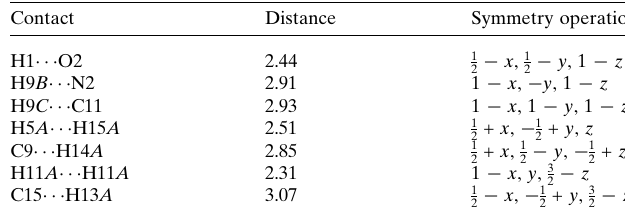
Table 2 Interatomic contacts of the title compound (A˚